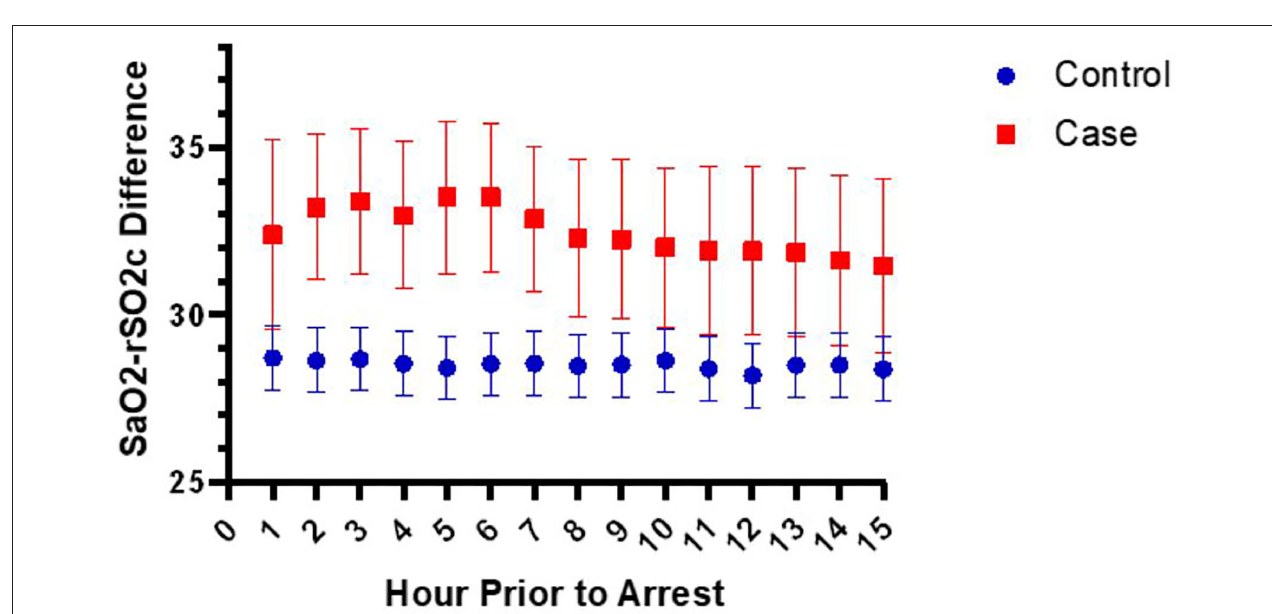
FIGURE 3 | Changes in the SaO2-rSO2c difference over